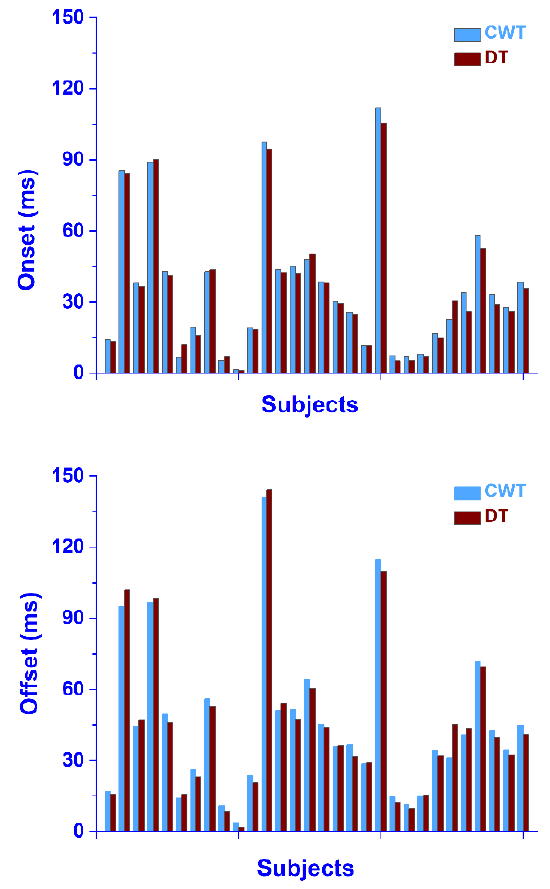
Figure 8. Average co-contraction onset and offset detected in early stance by CWT (cyan bars) vs. DT (brown bars) on real sEMG signals collected during walking. Values are expressed in ms, as the time–distance from the previous heel strike.